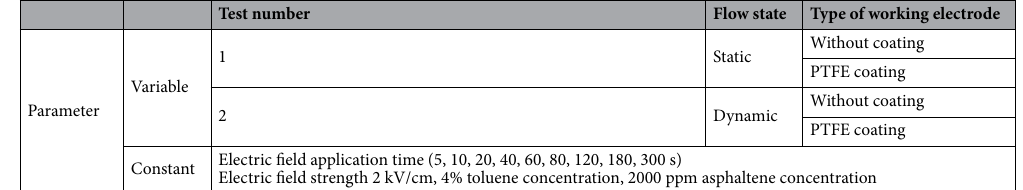
Table 4. The design of experiments to investigate the effect of flow type on the amount of asphaltene deposition.